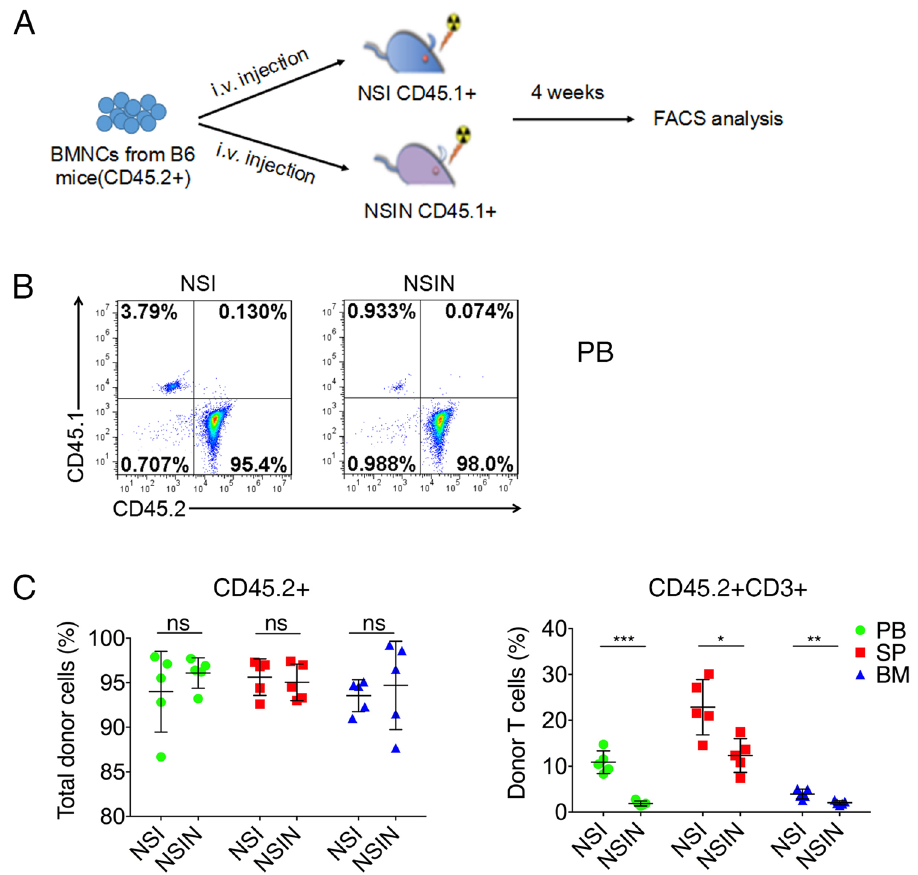
Figure 3. Allogeneic T cell development is affected in NSIN mice. ( A ) Schematic of the bone marrow transplantation (BMT). Bone marrow nucleated cells (BMNCs; 4 × 10 6 ) from C57BL/6J (B6) donor mice (CD45.2 + ) were injected into the retro-orbital venous sinus of lethally irradiated (2 Gy) NSI (CD45.1 + ) and NSIN (CD45.1 + ) mice. The engraftment of CD45.2 + donor cells was measured every week in the PB of recipients. Four weeks later, five animals in each group were euthanized to analyze the repopulation efficiency of donor cells and the development of donor T cells in the recipients. ( B ) At 4 weeks, BMNCs from B6 mice reconstituted to similar levels in the PB of both NSI and NSIN mice. CD45.2 + cells were derived from B6 mice. ( C ) The repopulation percentages of CD45.2 + donor cells (left) and CD45.2 + CD3 + T cells (right) in PB, SP, and BM; n = 5 for each group. Error bars denote the standard error of the mean (SEM). Groups were compared using a two-tailed unpaired t -test. * P < 0.05; ** P < 0.01; *** P <